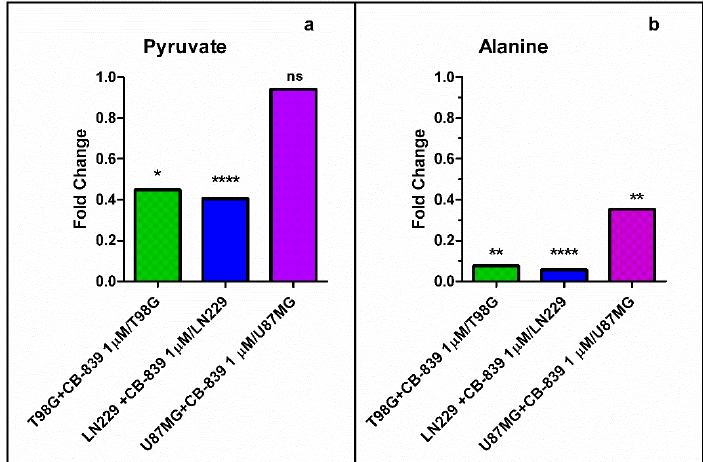
Figure 8. Pyruvate ( a ) and alanine ( b ) levels were diminished upon GLS inhibition by CB-839. The samples were run in triplicate. For more details, see Section 2. ns — non-significant. * p < 0.05, ** p < 0.01, **** p < 0.0001.